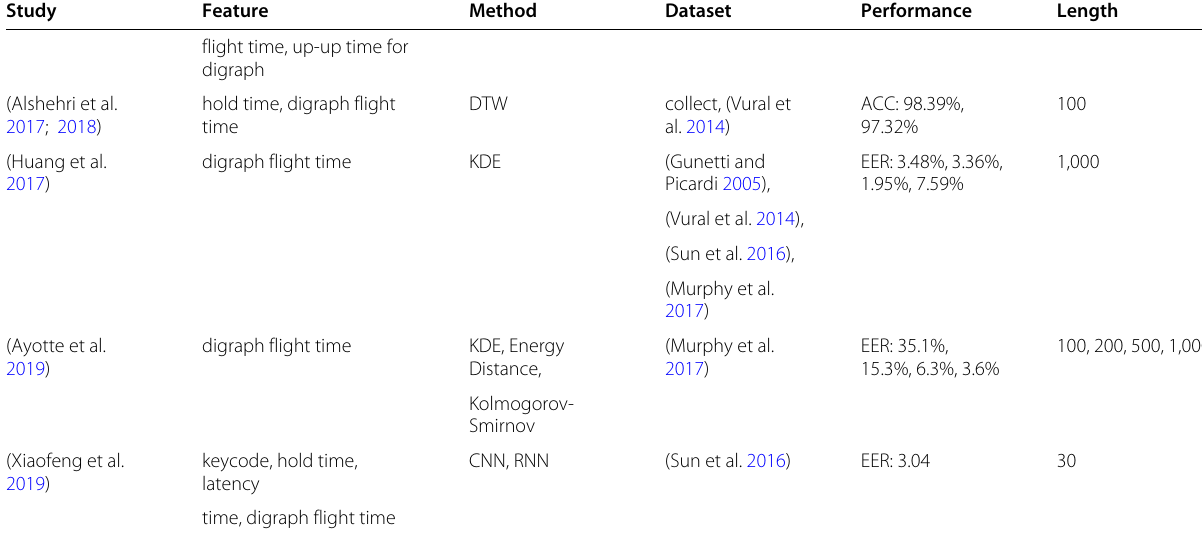
Table 1 Available KCA algorithms based on free-text keystroke dynamics ( Continued )